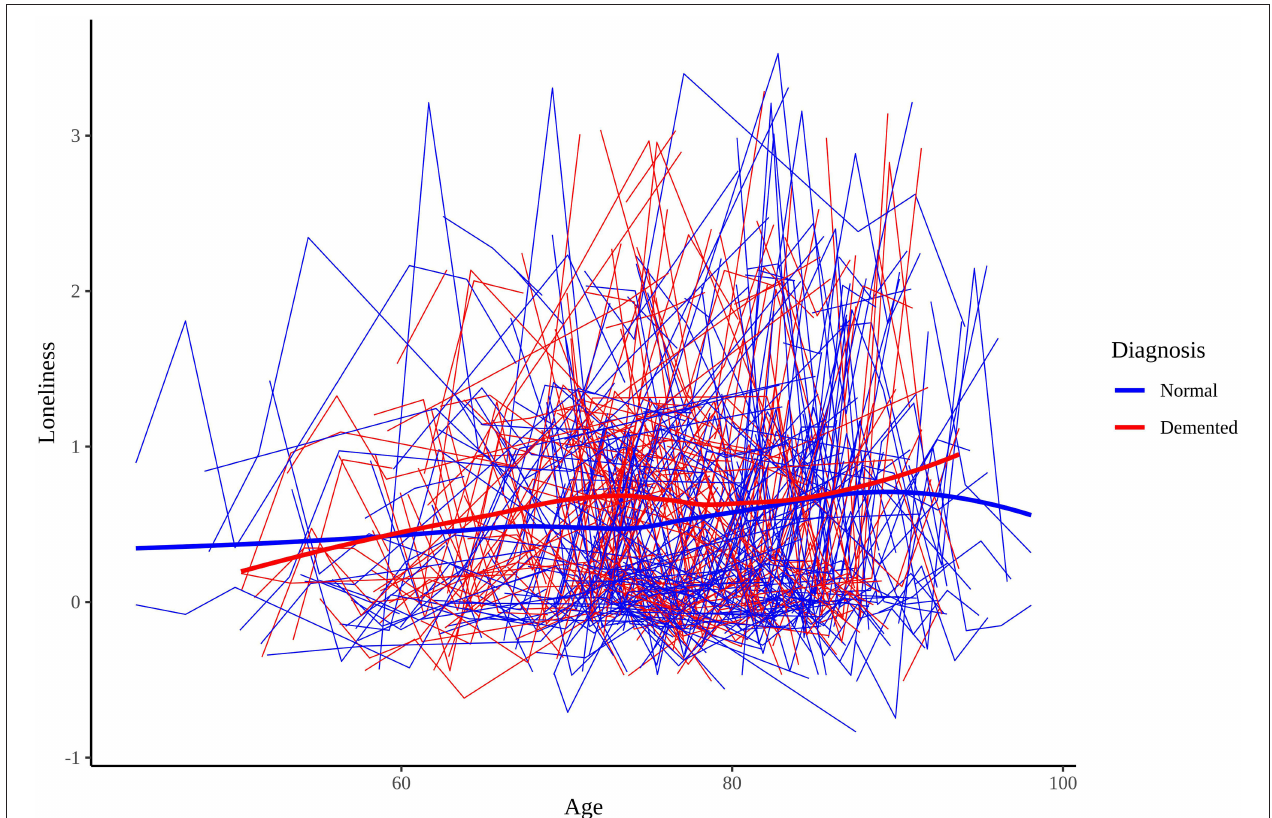
FIGURE 1 | Longitudinal trajectory plots of loneliness scores for 250 cognitively normal and 250 dementia diagnosed participants.